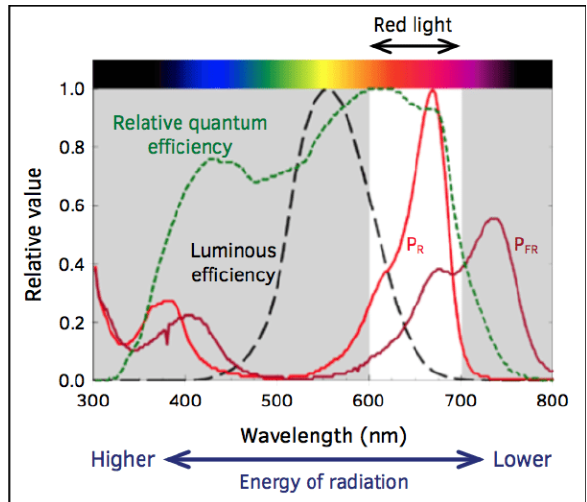
Figure 6. Effects of light waves on plants.